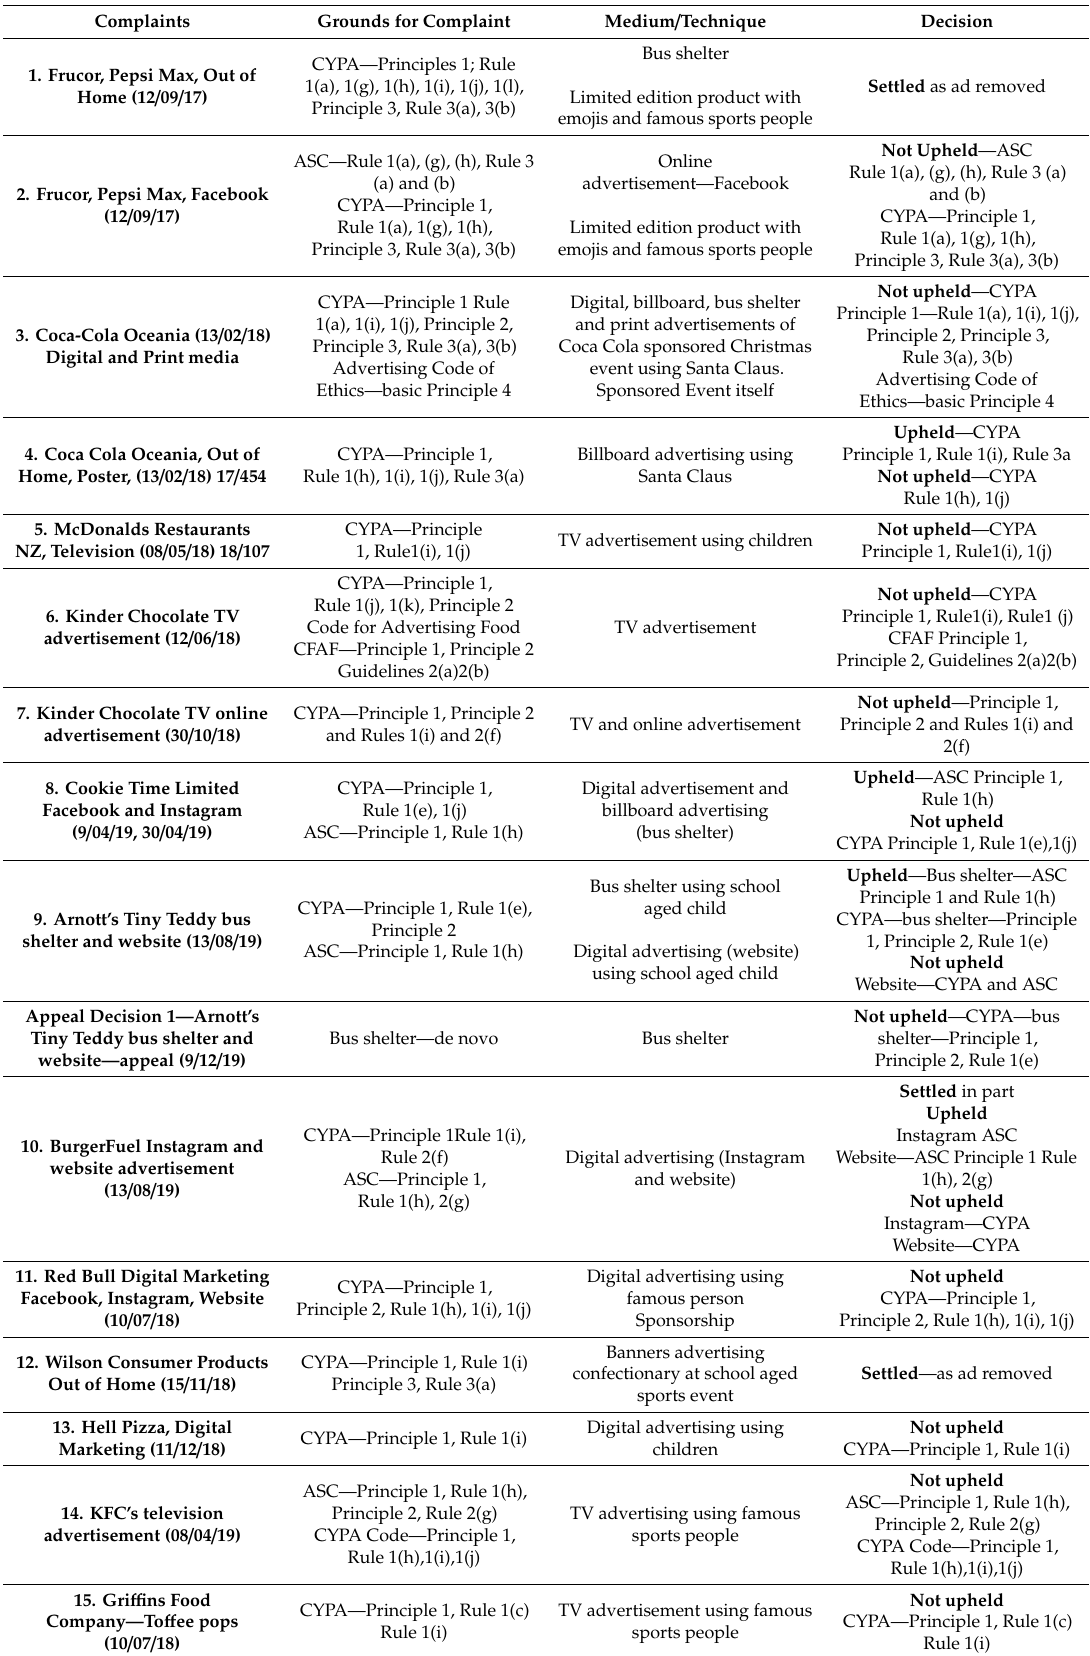
Table 1. Summary of